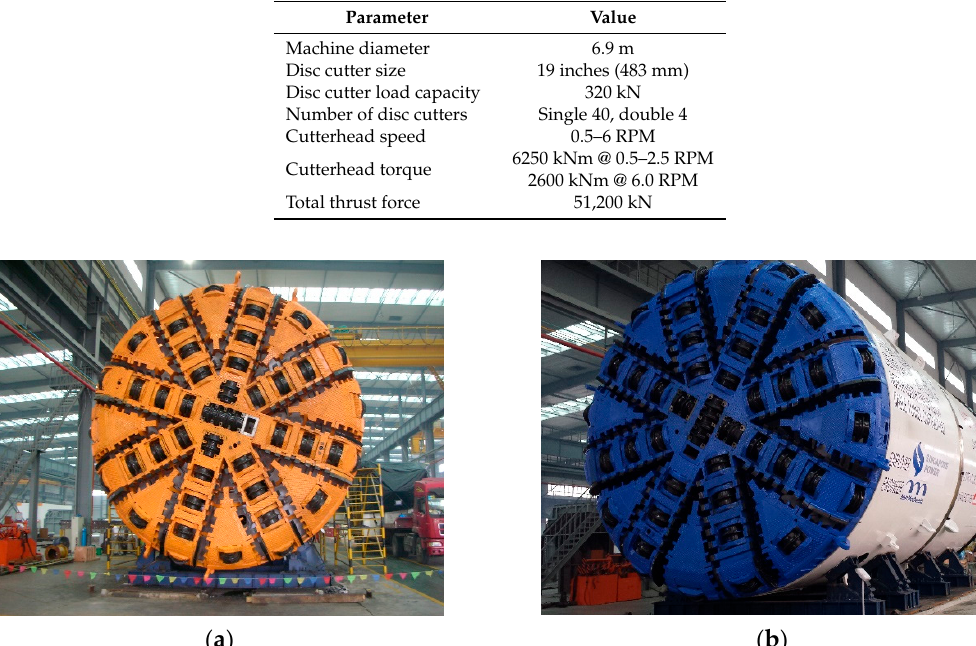
Figure 3. Photographs of tunnel boring machines (TBMs) used for the project: ( a ) TBM No. 1; ( b ) TBM No. 2. Appl. Sci. 2020 , 10 , x FOR PEER REVIEW